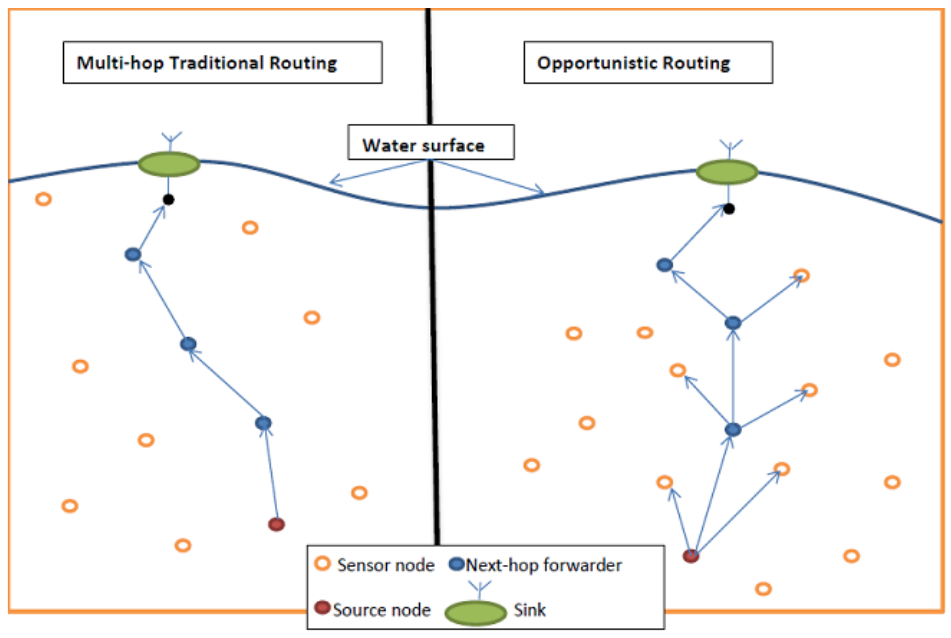
Figure 2. Multi-hop traditional routing vs. OR.